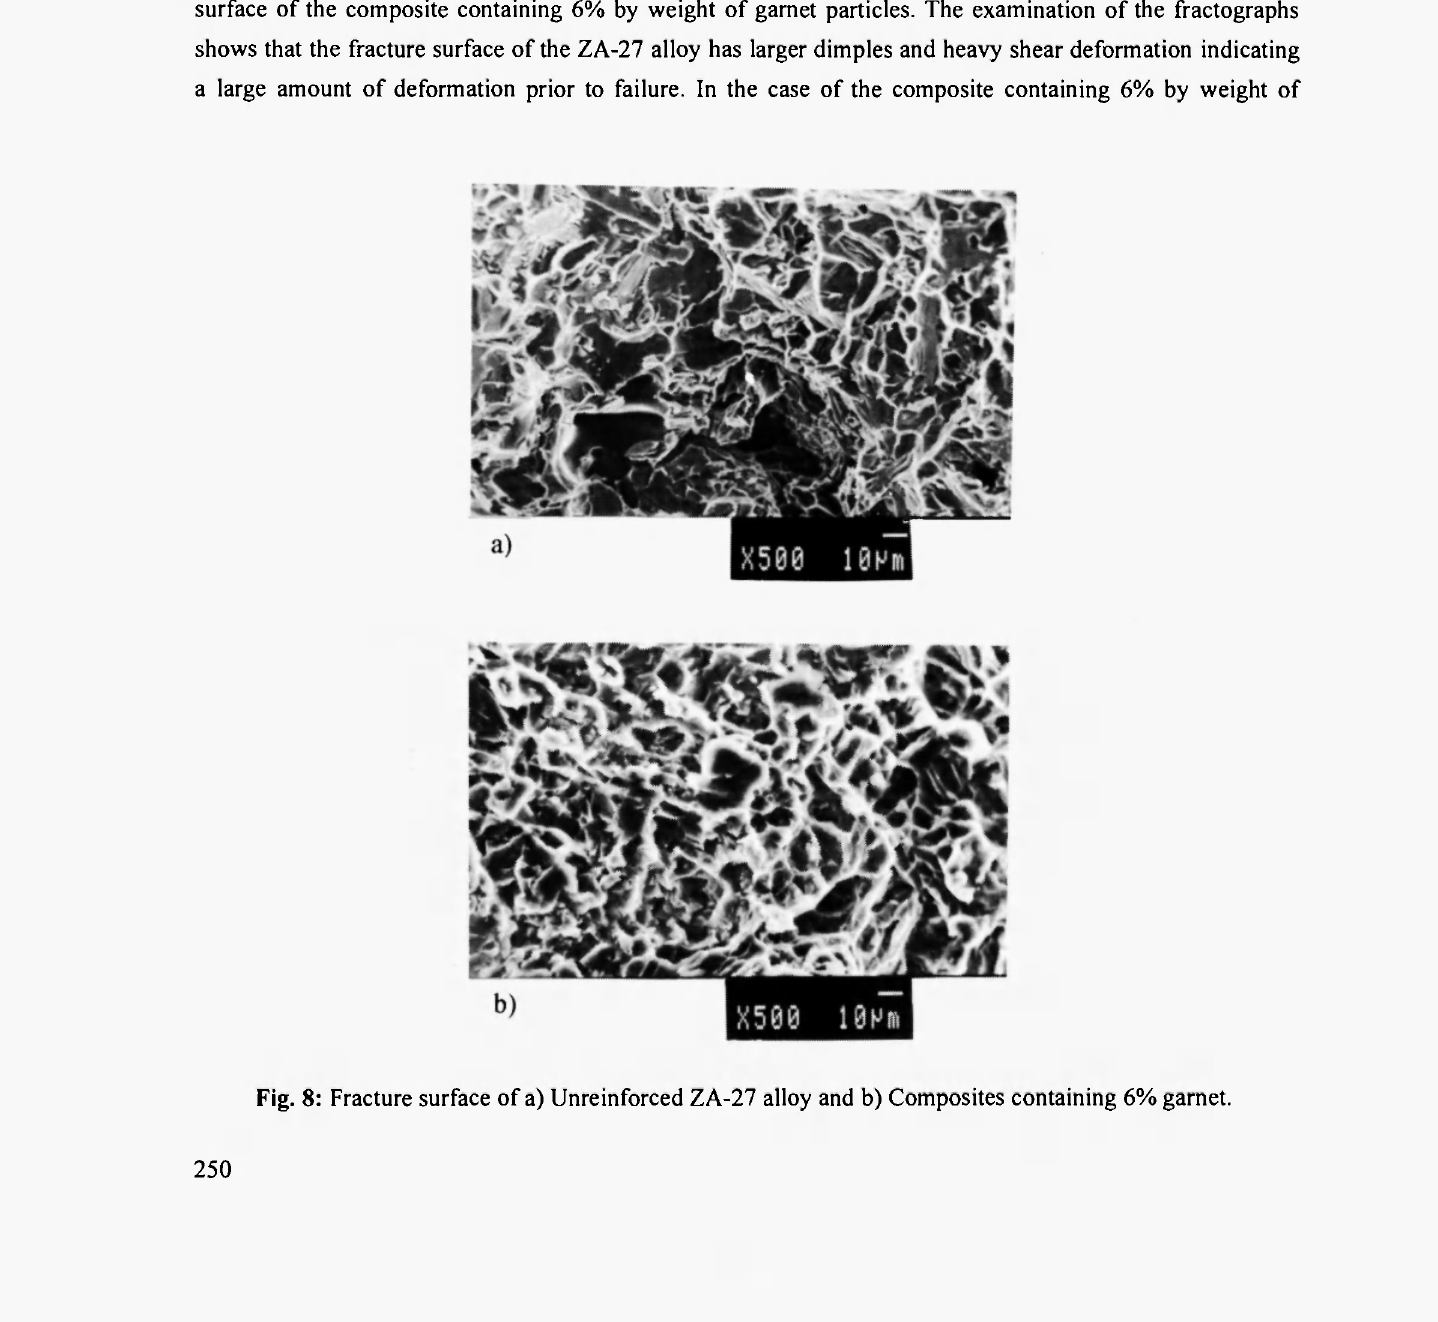
Fig. 8: Fracture surface of a) Unreinforced ZA-27 alloy and b) Composites containing 6%